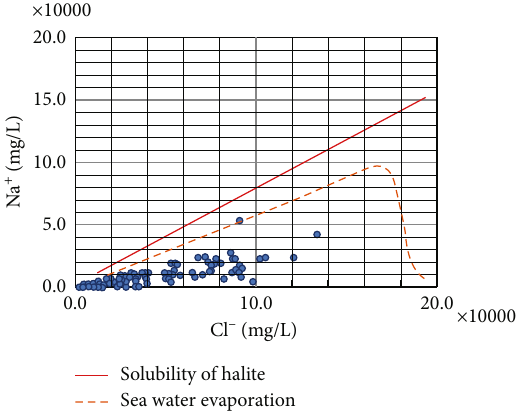
Figure 5: Comparison of Na + vs Cl − crossdiagram and theoretical evaporative dissolution